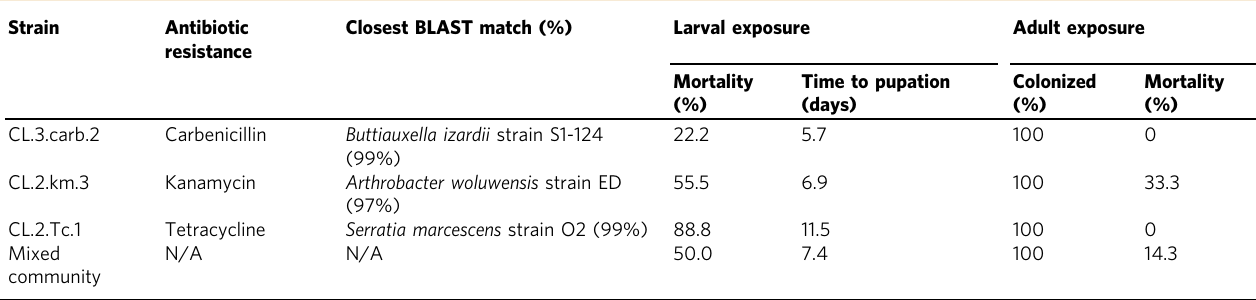
Table 2 Colonization of axenic larvae and adults with simpli fi ed microbiomes Strain